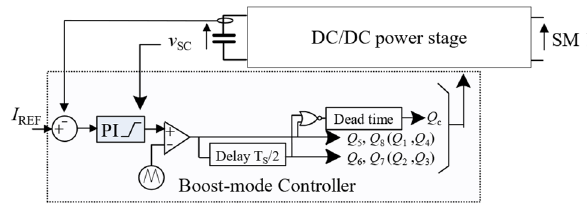
Figure 8. Boost-mode controller.